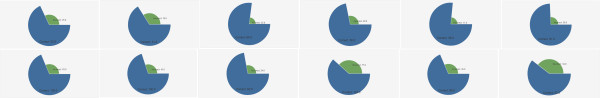
Results of all CART classifiers.